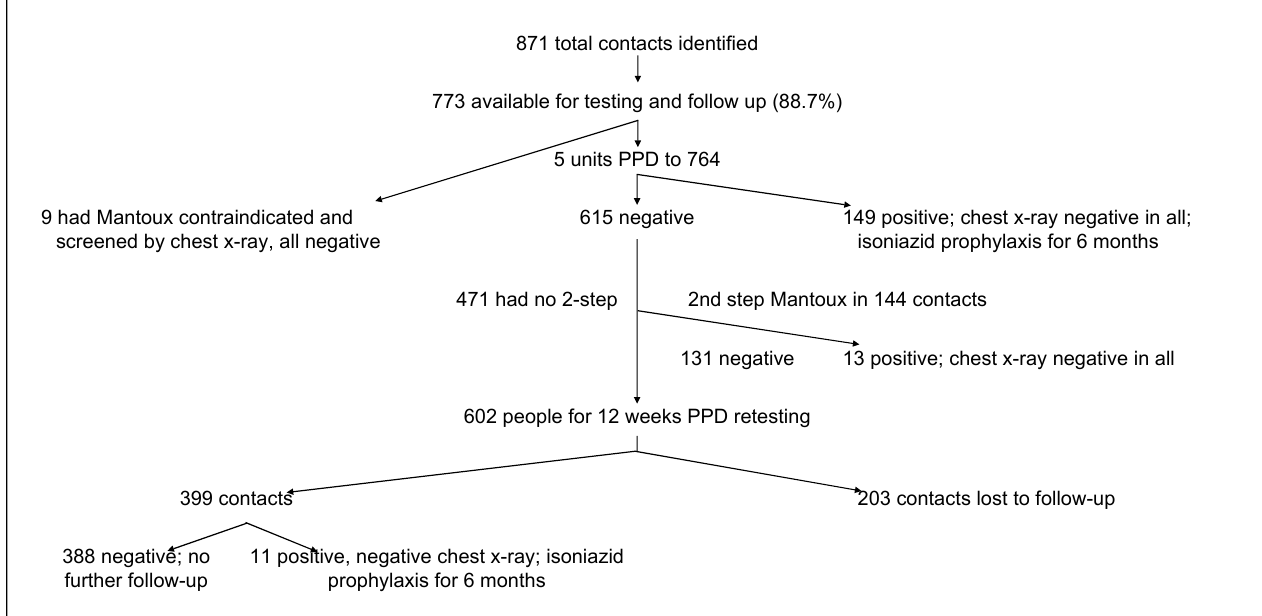
Fig ure 1) Re sults of tu ber cu lo sis follow- up at the Uni ver sity of Ot tawa. PPD Pu ri fied pro tein de riva